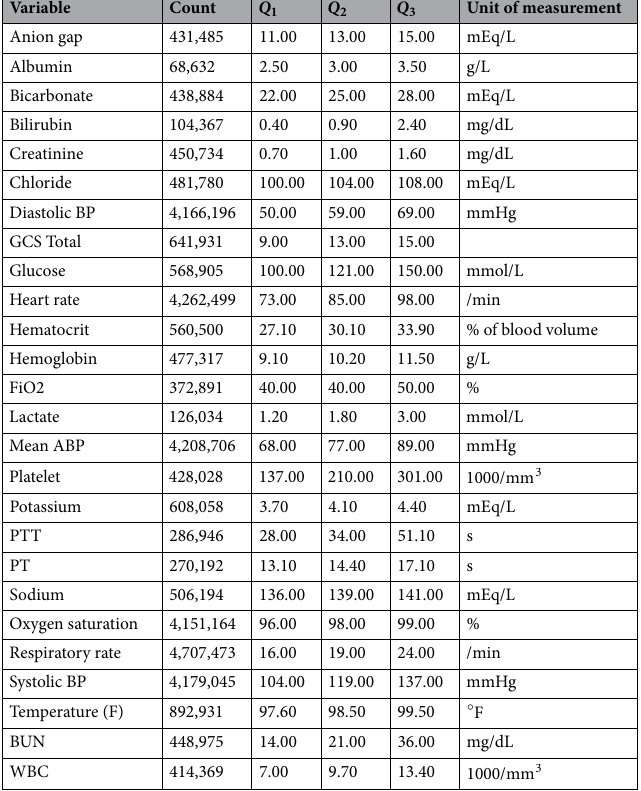
Table 2. Statistics for our subset of the MIMIC-III dataset used for model training, validation, and testing before truncation to 48 h. We present the lower quartile, median, and upper quartile values ( Q 1 , Q 2 , and Q 3 respectively) as, unlike mean and standard deviation, they are not skewed by the outliers deliberately kept in our dataset.